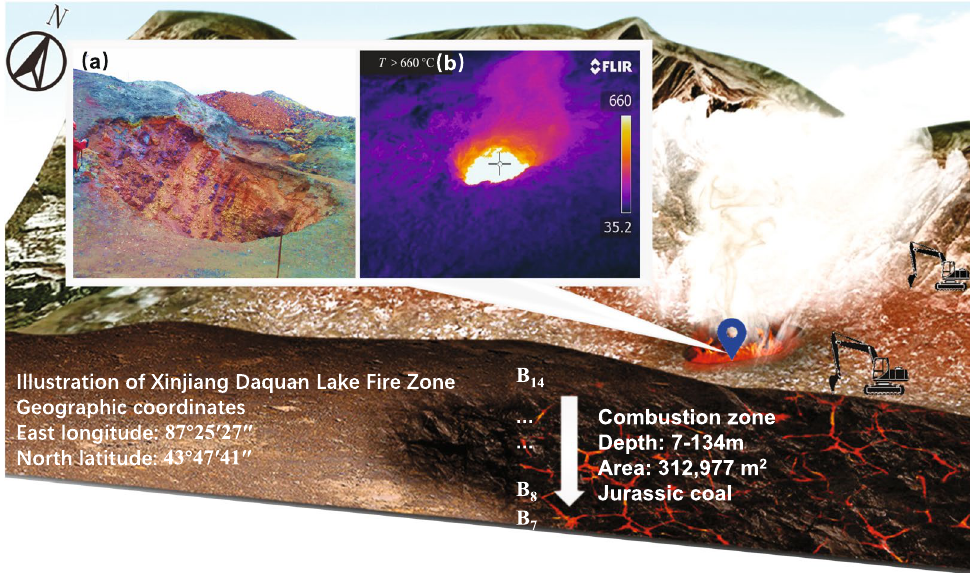
Figure 1. A crater spotted by underground coal fires ( a ) Physical map captured by authors ( b ) Temperature measured in the field (This map was created by AUTODESK ® 3DS MAX 2017. Link: http://www.autodesk.com. cn/products/3ds-max/free-trial).